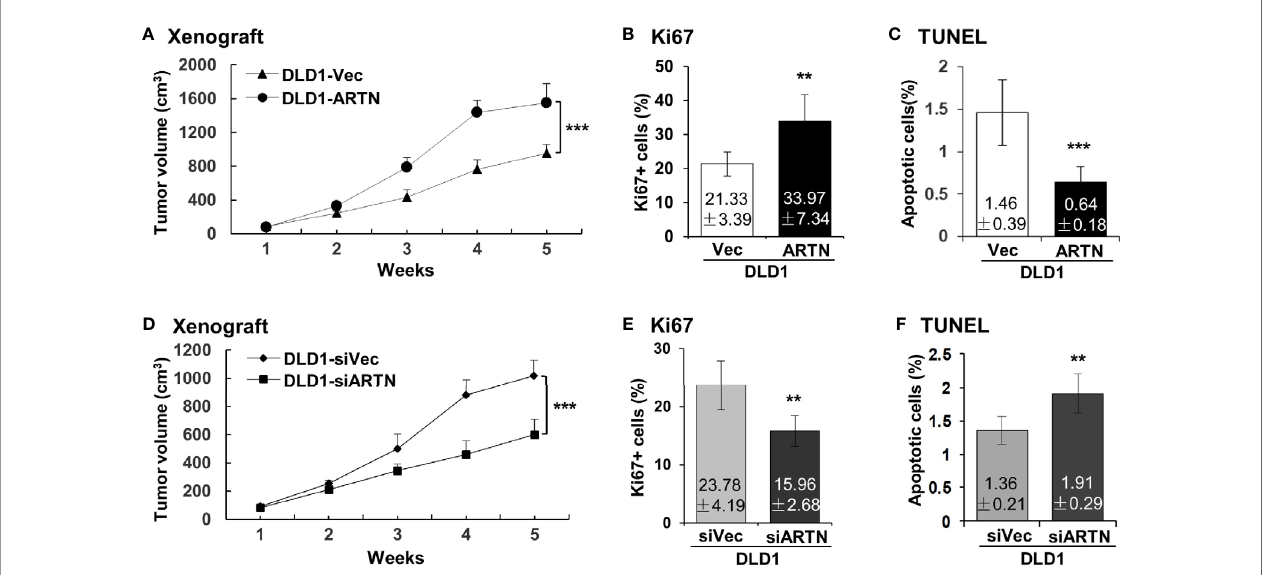
FIGURE 4 | ARTN promotes DLD1 xenograft growth. (A, D) , Subcutaneous tumor growth by DLD1 cells with stable forced expression of ARTN (A) or depletion of endogenous ARTN (D) . Cells were injected subcutaneously to immunocompromised mice. The tumor volume was measured once per week. The signi fi cance of differences in the tumor volume was analyzed by ANOVA. The mice were sacri fi ced when the fi rst tumor volume reached 1500mm 3 and the tumors were harvested. (B, E) , Ki67 staining to determine cell proliferation in the tumors. (C, F) , TUNEL assay to determine apoptosis in the tumors. Results were presented in fold change. ** p < 0.01, *** p < 0.001.